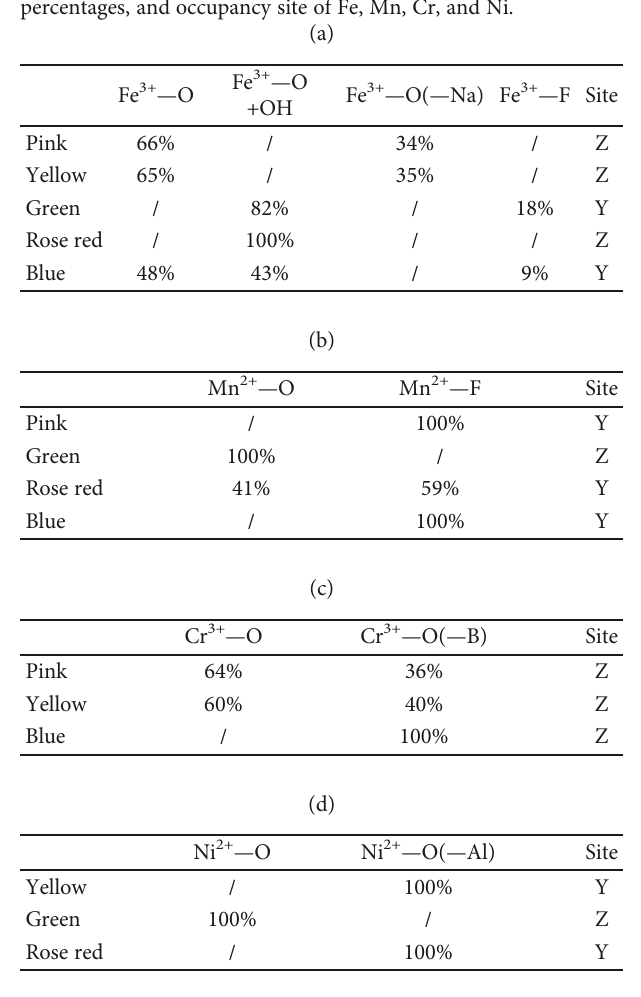
Table 1: Di ff erent binding con fi gurations, estimated atomic percentages, and occupancy site of Fe, Mn, Cr, and